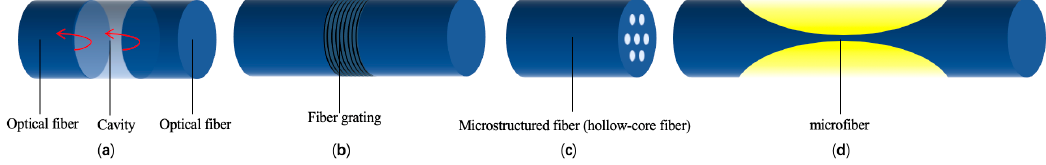
Figure 1. Fiber optofluidic (FOF) studies based on the structures of ( a ) the fiber-optic interferometer, ( b ) fiber grating, ( c ) microstructured optical fibers, and ( d ) optical microfibers.